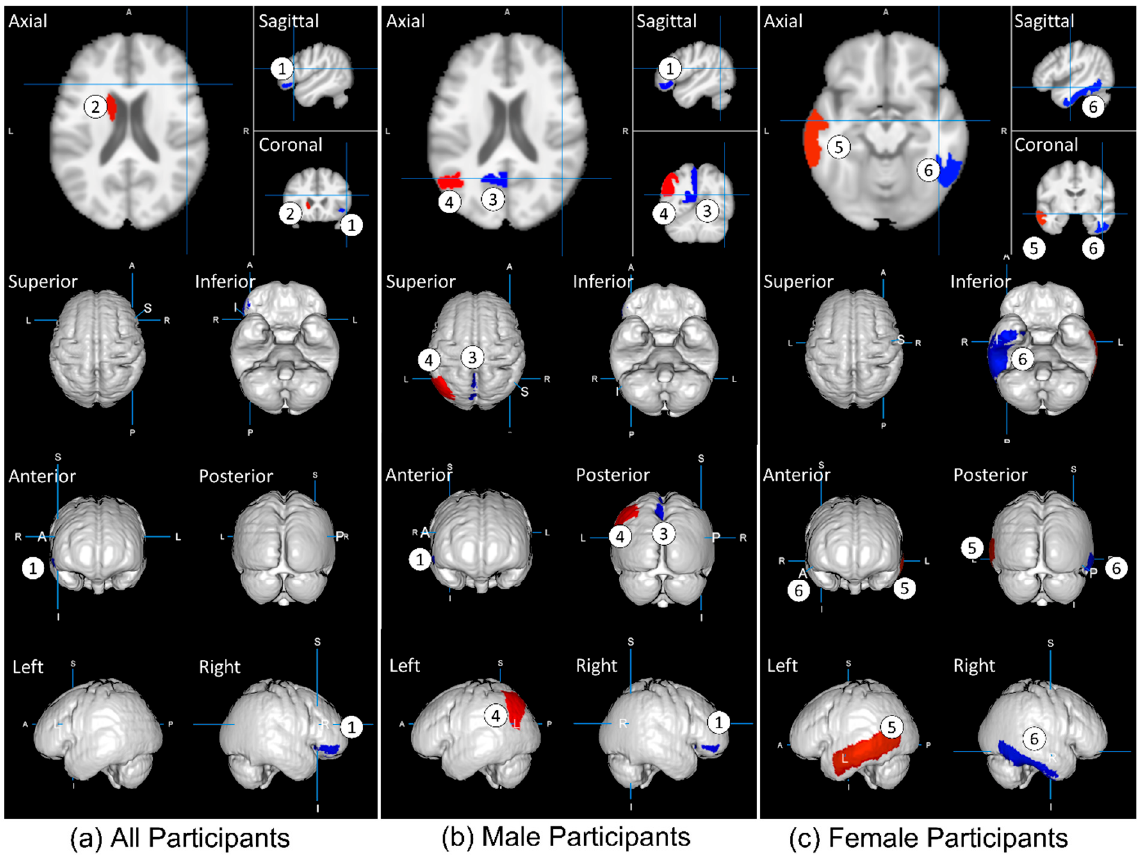
Figure 3. Impact of fatigue on the gray matter volume of the participants: ( a ) all participants; ( b ) male participants; ( c ) female participants. The most significant regions as predictors are presented in Table 2 and are color-coded with red for a positive correlation and blue for a negative one. The rGMVs are as follows: (1) right orbital part of the inferior frontal gyrus; (2) left caudate; (3) left precuneus; (4) left angular gyrus; (5) left middle temporal gyrus; (6) right temporal gyrus.